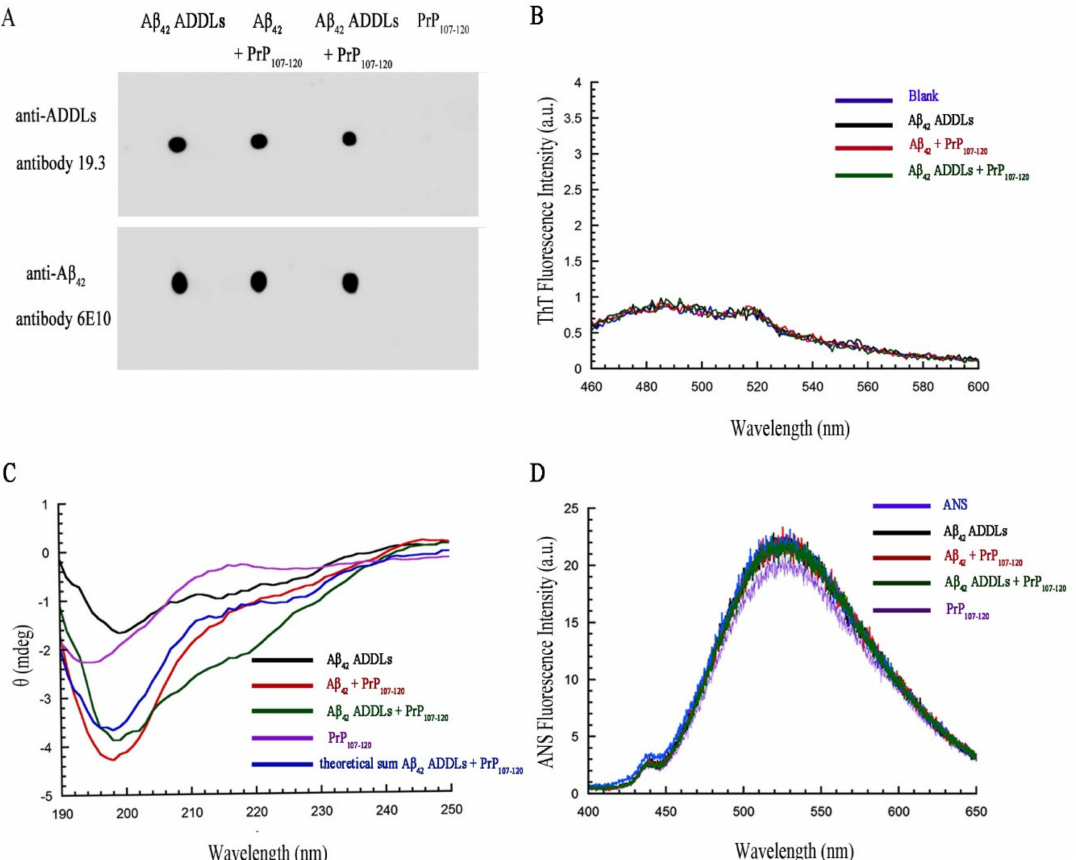
Figure 8. E ff ect of PrP 107–120 on A β 42 ADDL structure. ( A ) Dot-blot immunoassay for A β 42